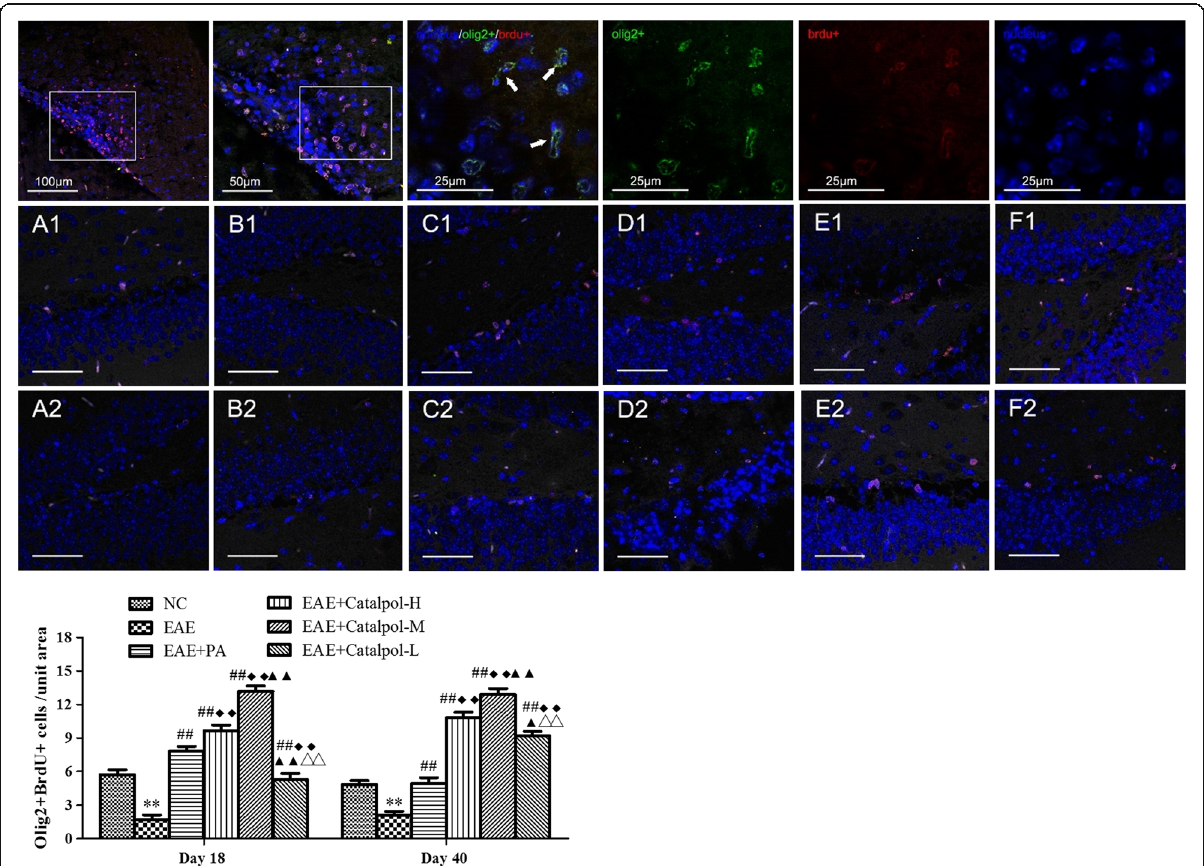
Fig. 9 Confocal images in the hippocampus DG of mice double labeled with nucleus ( blue ), Olig2 ( green ) and BrdU ( red ). Olig2 was expressed in cytoplasm of cells ( arrows ). A1 to F1and A2 to F2show the Olig2+/BrdU+ in the brains of mice on Day 18 andDay40 in NC ( n = 4), EAE ( n = 4), EAE+ PA ( n = 4), EAE + Catalpol – H ( n = 4), M ( n = 4) and L ( n = 4) mice, respectively (scale bar 50 μ m). The protein expressions of Olig2/BrdU in the brains of mice were analyzed. Note: ** P < 0.01 vs. NC, ## P < 0.01 vs. EAE; ◆◆ P < 0.01 vs. EAE+ PA; ▲ P < 0.05, ▲▲ P < 0.01 vs. EAE + Catalpol – H, △△ P < 0.01 vs. EAE + Catalpol –